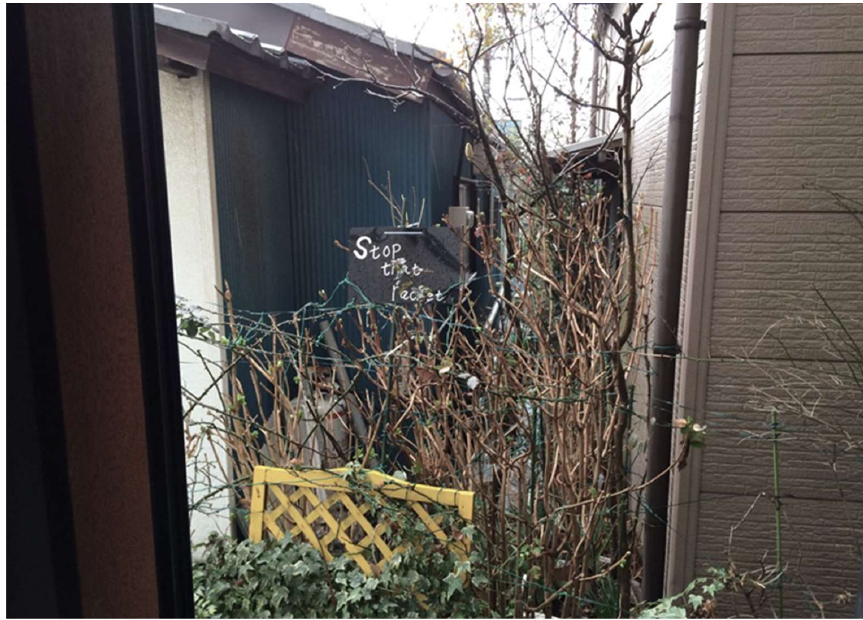
Figure 3. The sign and barbed wire in front of the door of the Indonesian migrants’ apartment.